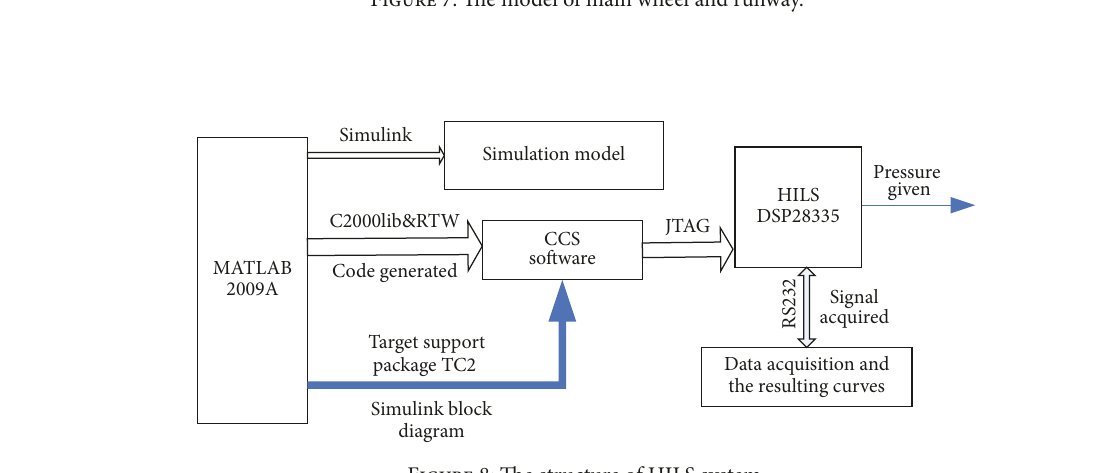
Figure 7: The model of main wheel and runway.